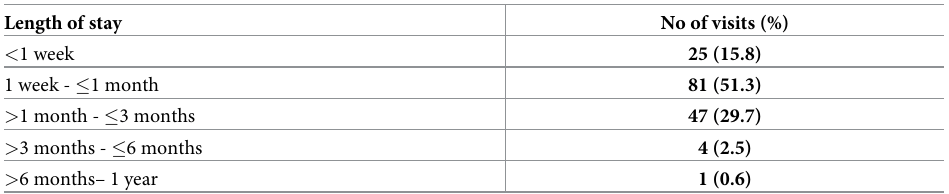
Table 5. Length of stay in